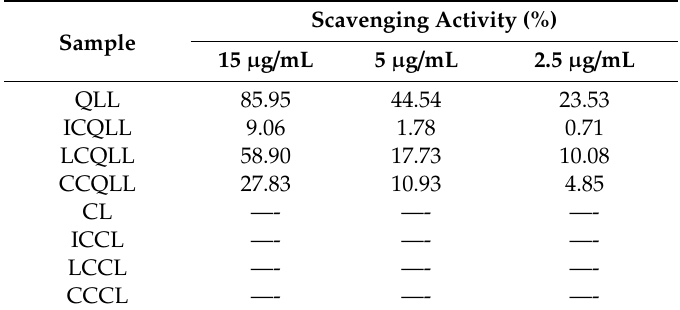
Table 2. Summary of antioxidant activity of uncoated and polysaccharide coated quercetin loaded liposomes at di ff erent concentrations.